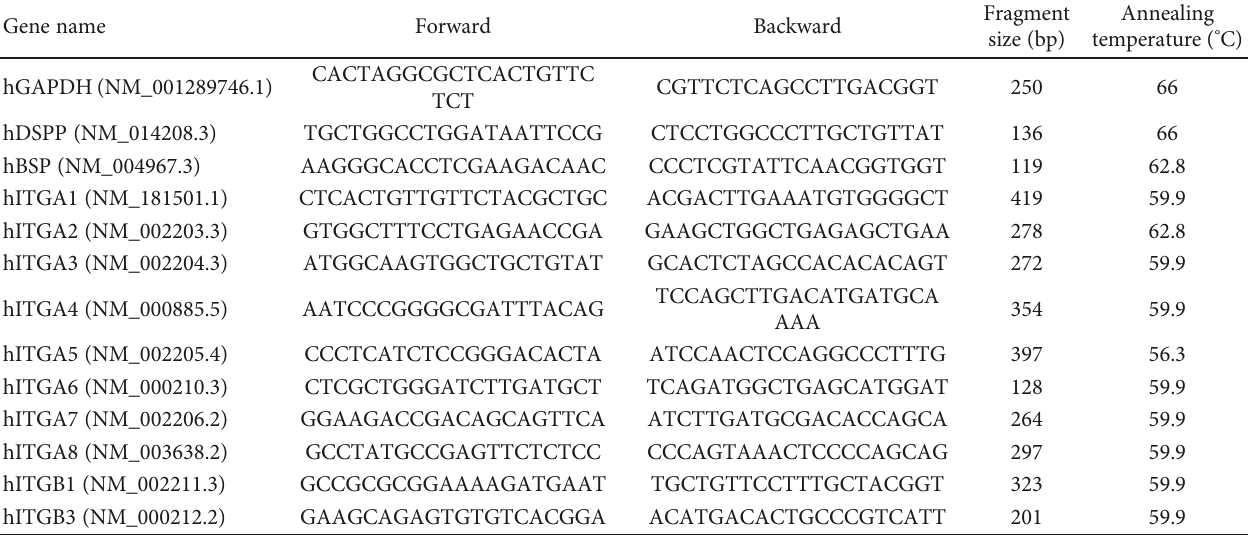
Table 1: Primer sequence, fragment size, and annealing